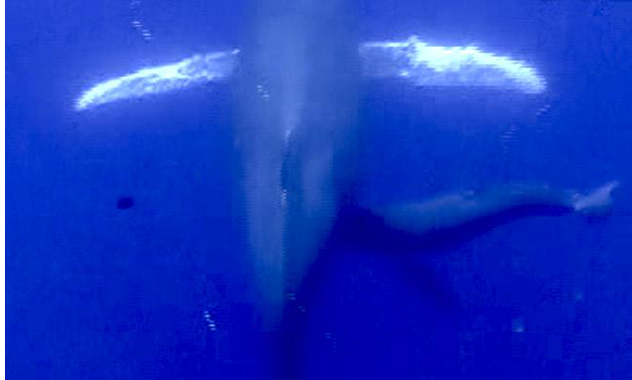
Figure 1. Focal Group 1 where calf approached and positioned on right side, remaining in the suckling position for duration of 55 s.